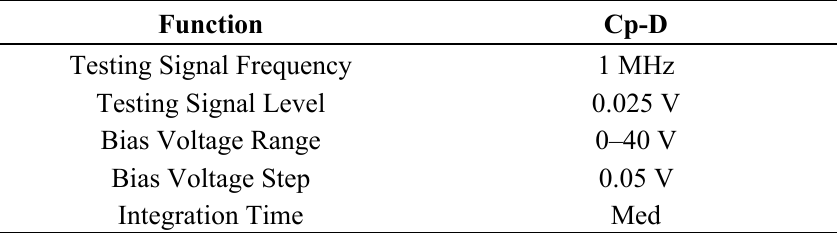
Table 5. Measurement